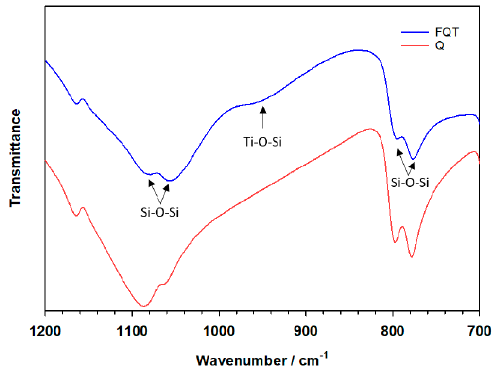
Figure 3. FTIR spectra of bare quartz (Q) and the TiO 2 –SiO 2 –Quartz composite (FQT).